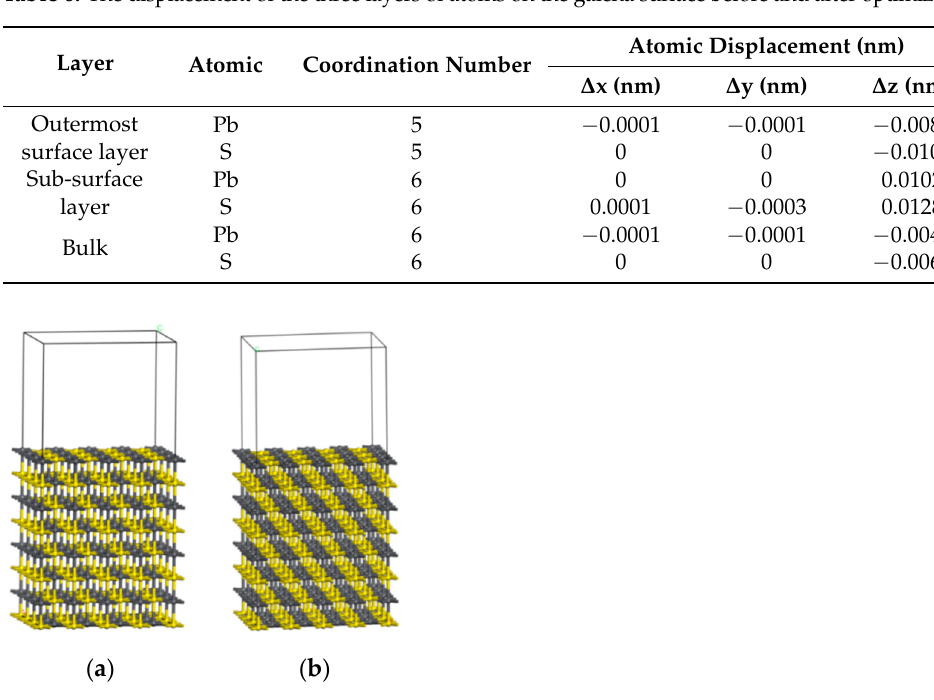
(b) are displayed in Figure 8.